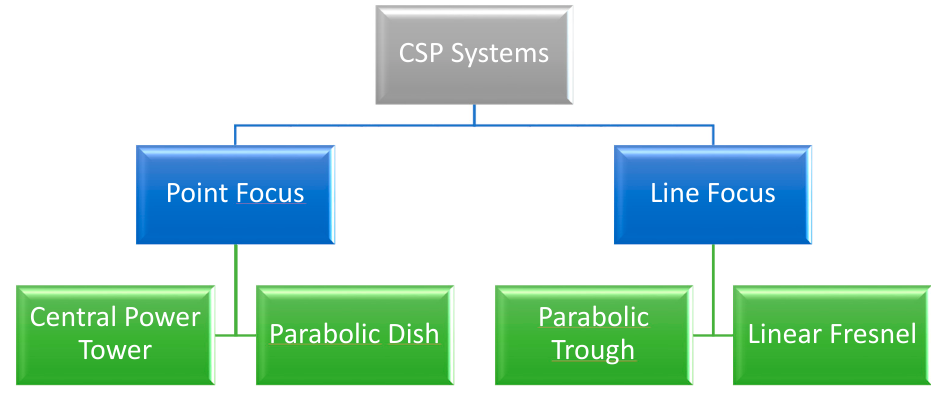
Figure 1. Overview of main concentrating solar power technologies.